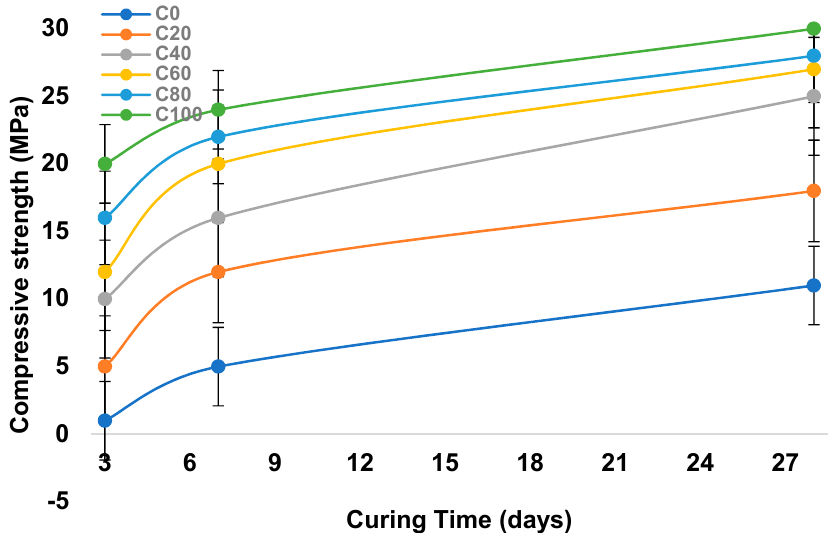
Figure 7. Effect of curing period on the compressive strength of geopolymer.